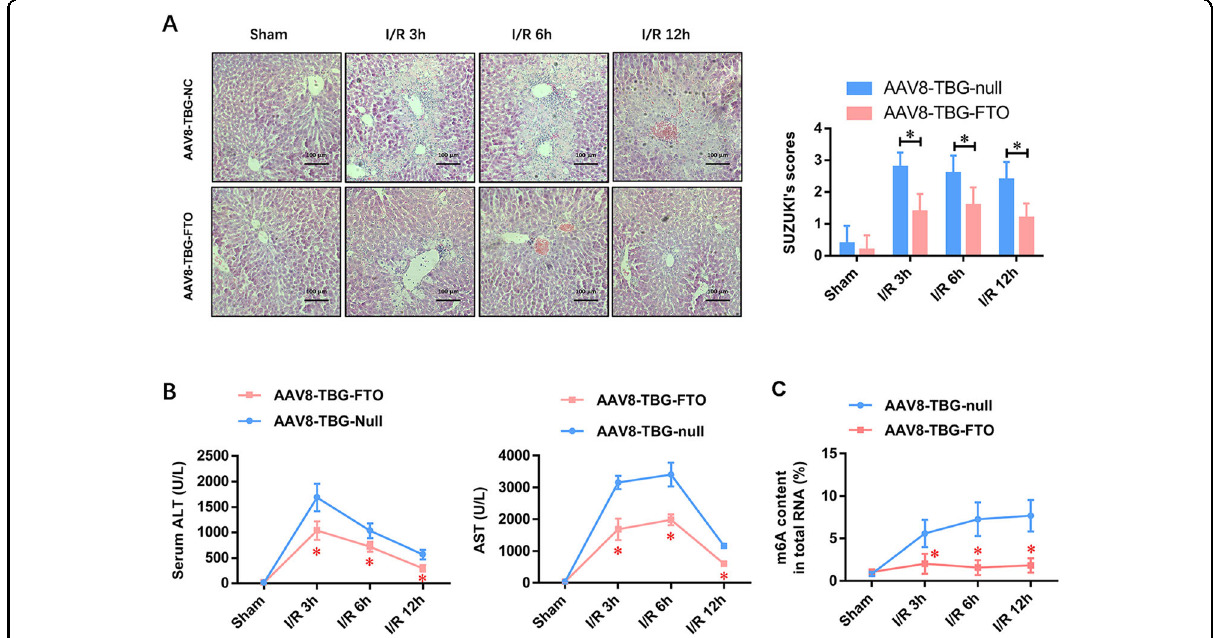
Fig. 2 Adeno-associated virus-mediated liver-speci fi c overexpression of FTO (AAV8-TBG-FTO) attenuates the HIRI and represses the elevated level of m6A methylated RNA in vivo. A Representative histopathologic images of liver sections harvested at 24 h after reperfusion (H&E staining; scale bars, 100 μ m). The damage degree was graded using Suzuki criteria. B Blood samples were collected to determine the ALT and AST levels (U/L). C The total level of methylated RNA (m6A) in hepatic tissues was detected by EpiQuik m6A RNA Methylation Quanti fi cation Kit. N = 5; * P < 0.05 vs. AAV8-TBG-NC